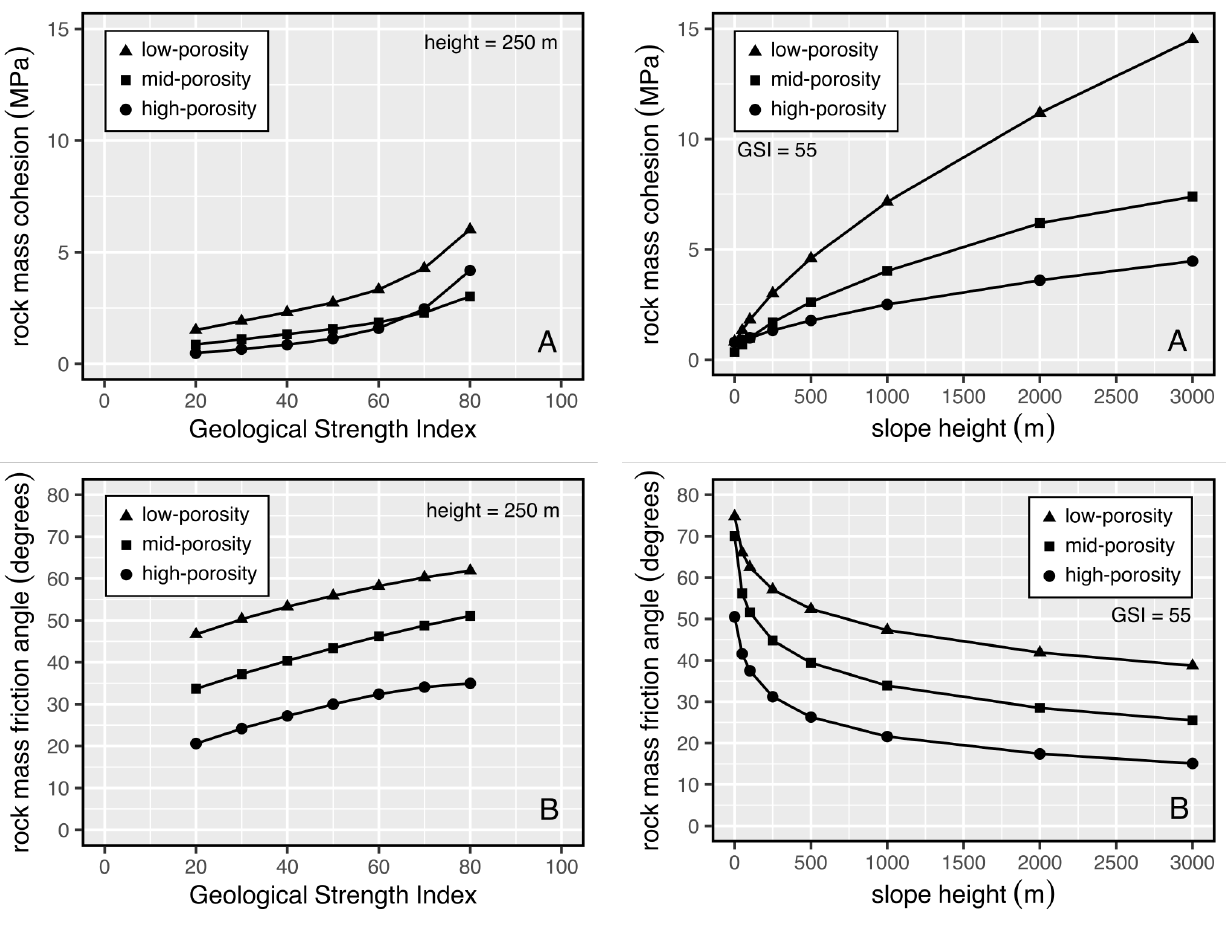
Figure 5: Rock mass cohesion [A] and friction angle [B] as a function of Geological Strength Index (GSI) for low, moderate, and high porosity volcanic rocks with a slope height of 250 m and a density of 2650 kg m − 3 , calcu- lated from the m i values in Table 2.